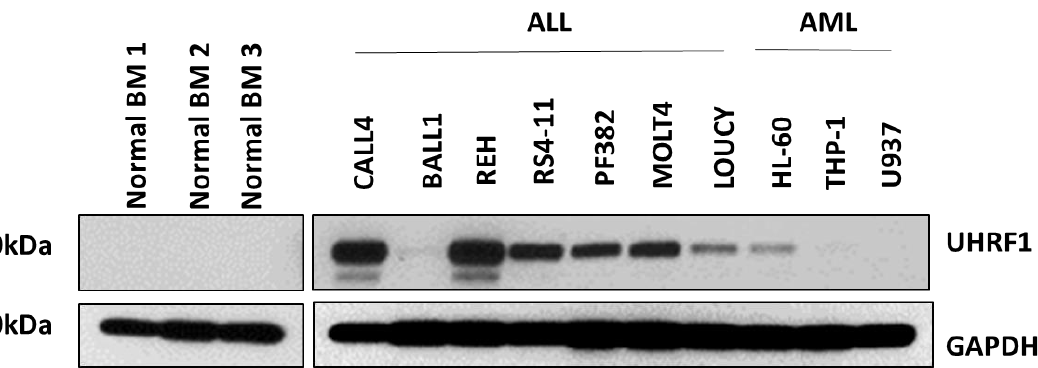
Figure A2. UHRF1 protein expression in healthy-donor bone marrow-derived cells as well as in immortalized ALL and AML cell lines. The uncropped blots are shown in Figure S1.